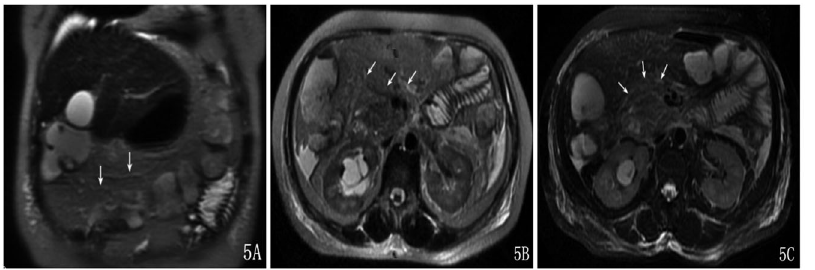
Figure 5. A 56-year-old female with moderate AP and TMI was Grade II. The transverse mesocolon showed edema and thickening on a coronal SSFSE T2-weighted image (A), on an axial SSFSE T2-weighted image (B) and on an axial SSFSE T2-weighted image with fat suppression